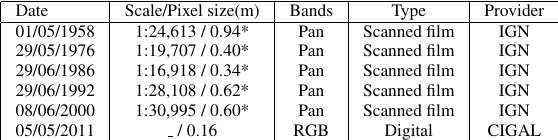
Table 1. Specifications for the selected aerial photographs. * For scanned films, scale is followed by a pixel size estimate that was computed using calibration certificates.